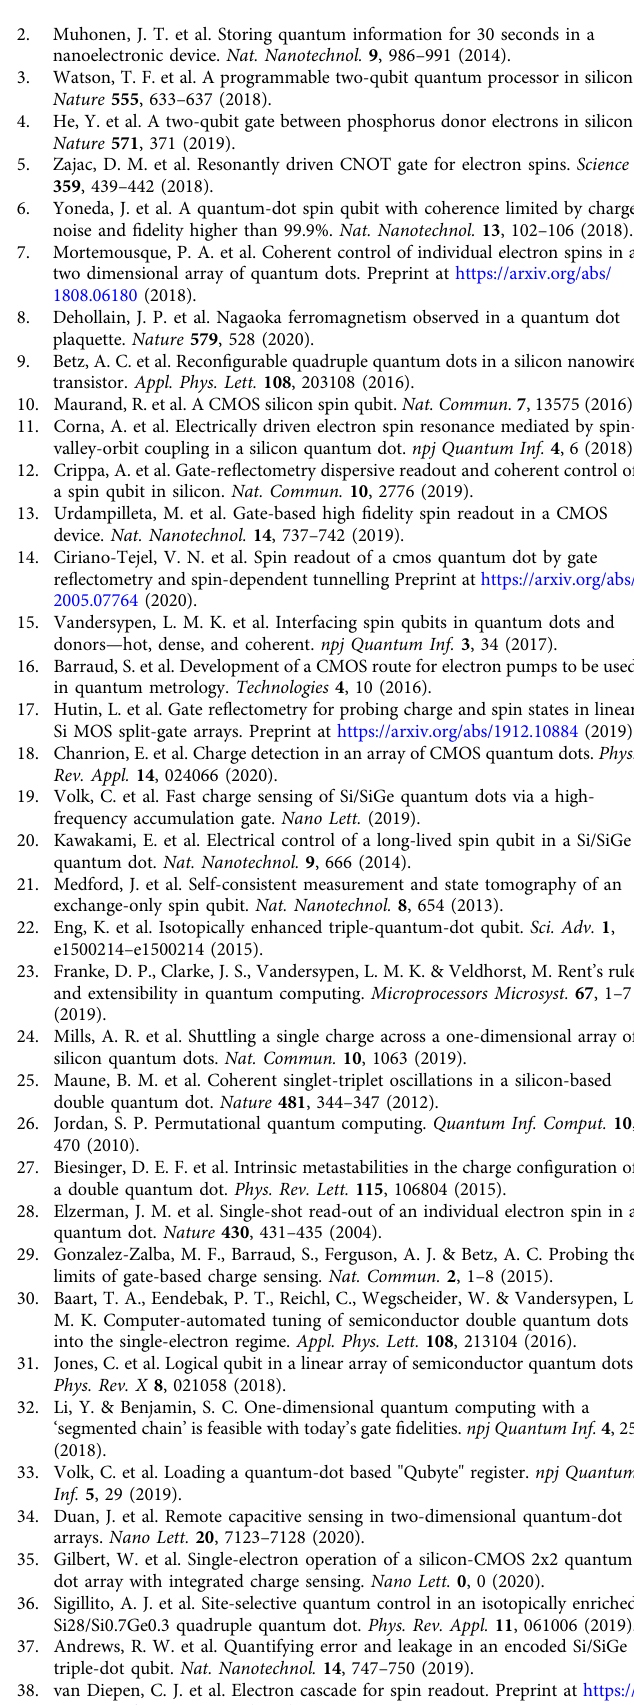
Table S2. The observed spread in extrapolated threshold voltages for different gate electrodes (of order 40 mV) is comparable to the change of voltage thresholds when warming the device to room temperature and cooling it back down, consistent with homogeneous gate de fi nition during fabrication. Reporting summary . Further information on research design is available in the Nature Research Reporting Summary linked to this article. Data availability The datasets generated and analyzed during the current study are available from the corresponding author (F.K.) upon reasonable